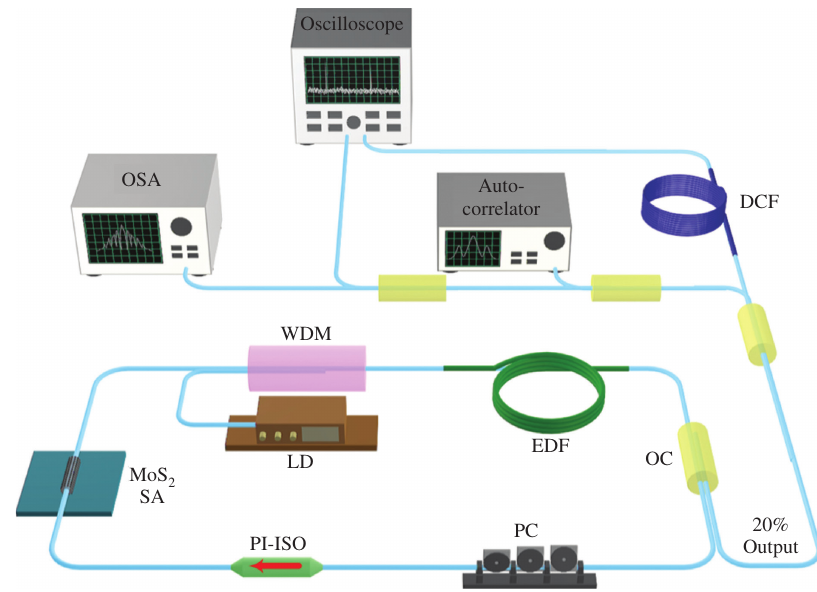
SA-based mode-locked fiber 2